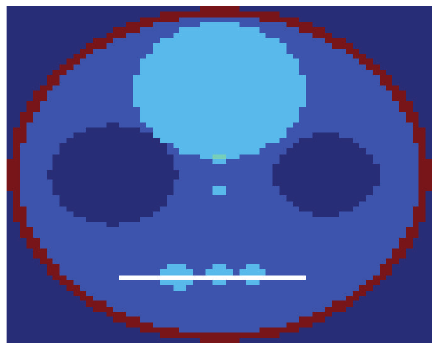
Figure 9: Illustration of line used for profile